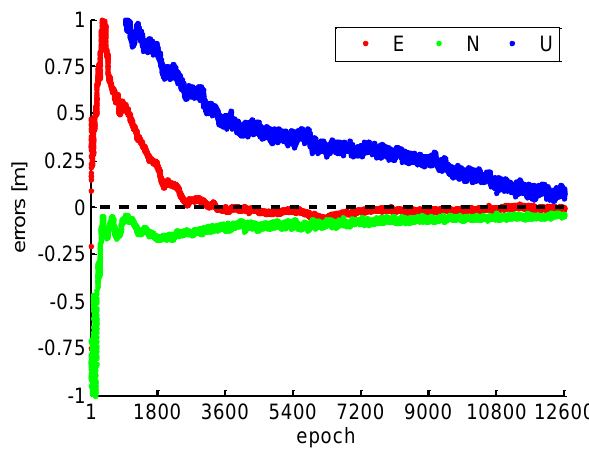
Figure 1. Positioning errors of conventional kinematic precise point positioning (PPP).